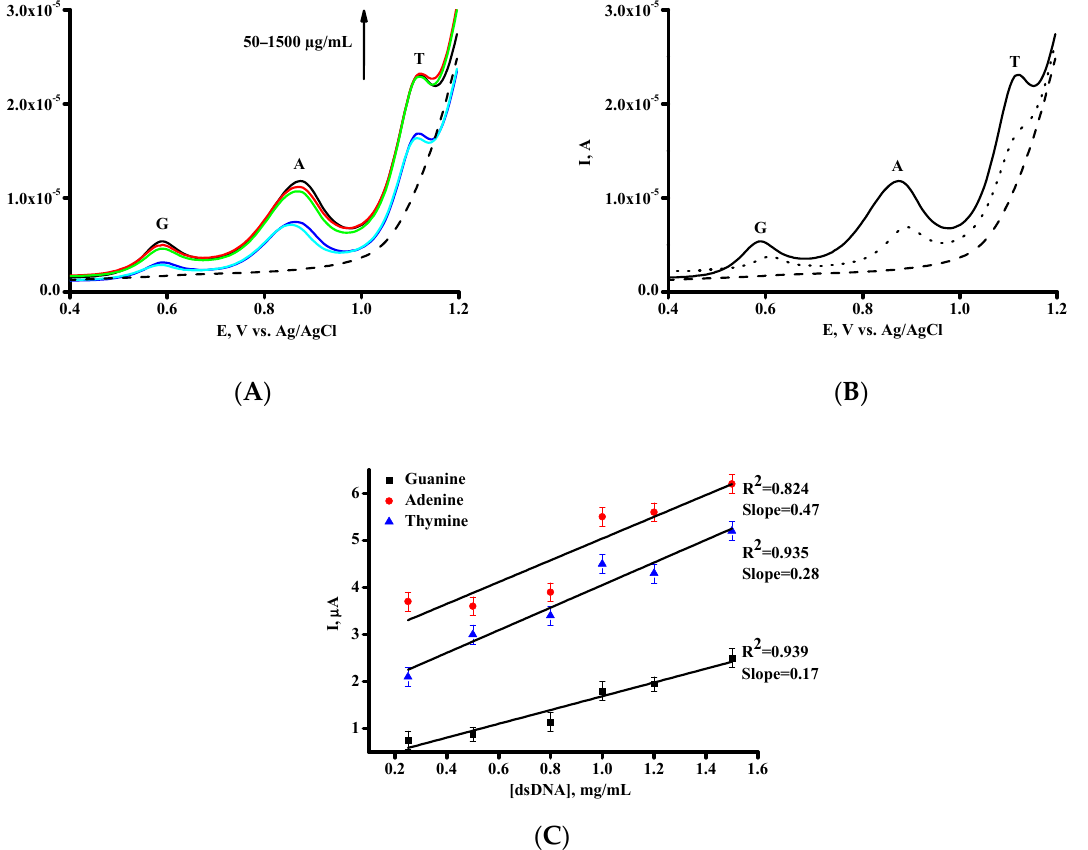
Figure 3. ( A ) DP voltammograms for SPE/SWCNT after deposition of dsDNA in the concentration range of 50–1500 µg/mL, SPE/SWCNT (dash line); ( B ) DP voltammograms for SPE/SWCNT (dash line) after deposition of DNA 1500 µg/mL (-) first scan, (…) second scan; ( C ) Calibration graph presenting the oxidative peak current I G of guanine (G) residues at E = 0.59 ± 0.01 V, I A of adenine (A) residues at E = 0.88 ± 0.01 V, I T thymine (T) residues at E = 1.12 ± 0.01 V versus the concentration of dsDNA.